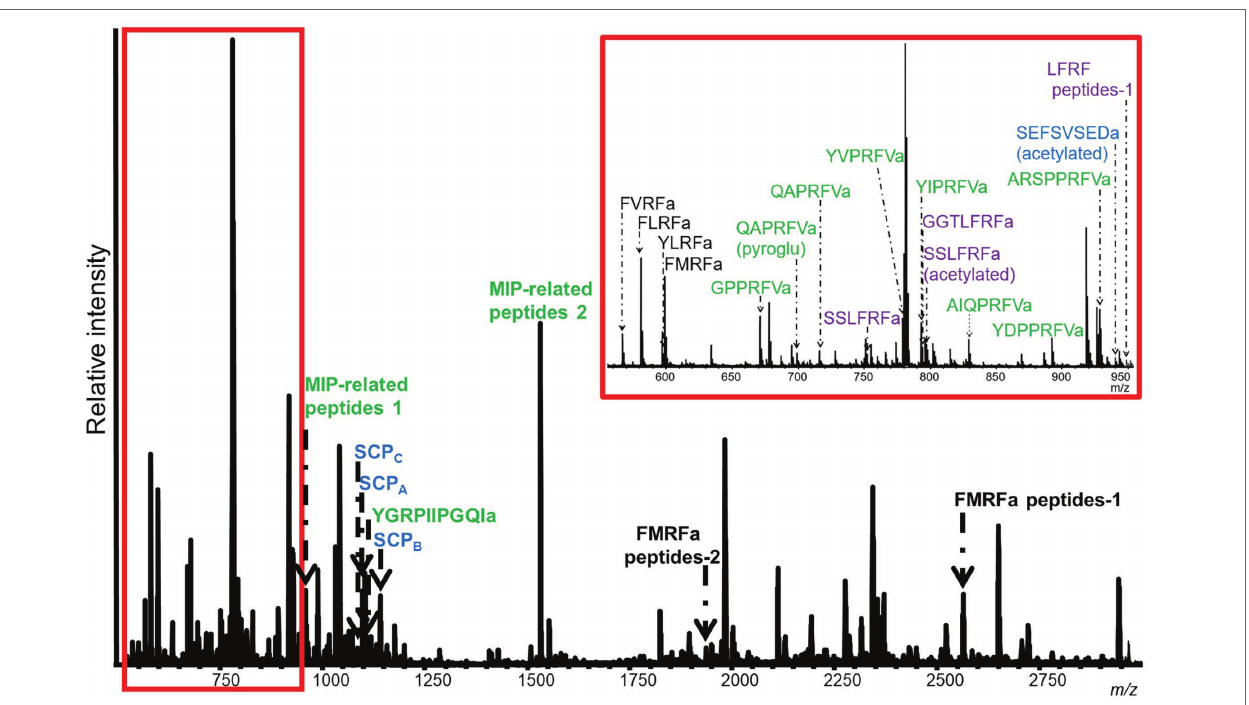
FIGURE 3 | Representative MALDI-TOF MS spectrum from a M. leonina SLB cell. Four neurons were analyzed. This cell expressed 11 peptides from the MIP-related prohormone (green), six peptides from the FMRFa prohormone (black), and four peptides from the SCP (blue) and LFRFa (purple) prohormones. Peptides from the MIP-related prohormone included eight, with either a PRFVa or PTFVa C-terminal motif. The peptides from the SCP prohormone included SCP A , SCP B , and SCP C . Four of the six peptides from the FMRFa were tetrapeptides, including FMRFa itself. Lastly, the peptides from the LFRFa prohormone included both an acetylated and unacetylated version of